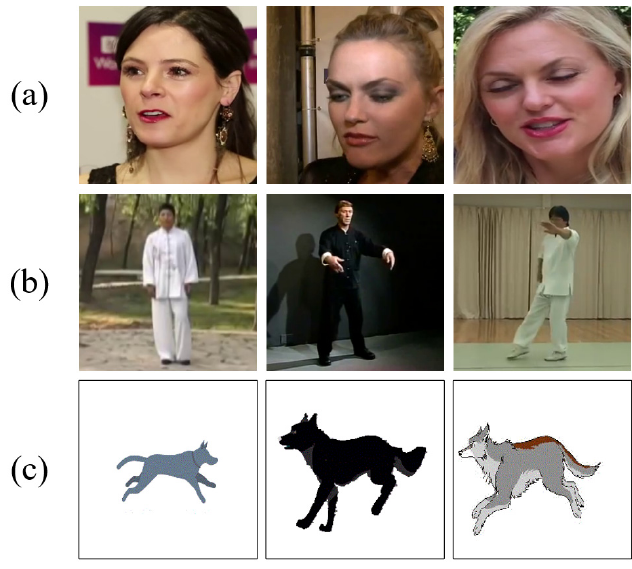
Figure 10. Examples of experimental datasets. ( a ) TaiChiHD; ( b ) VoxCeleb; ( c )